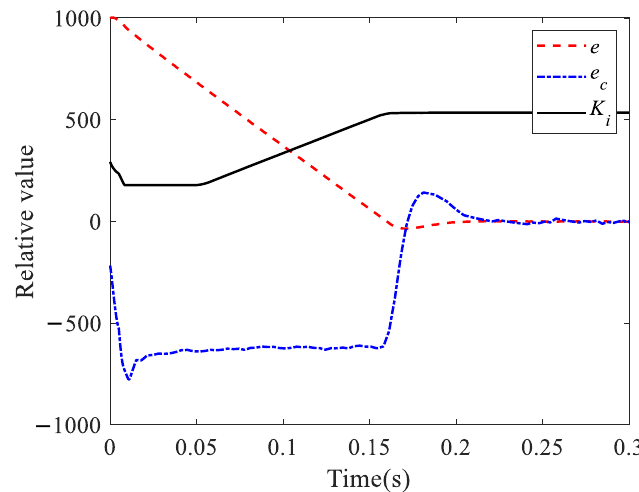
Figure 5. Adaptive sensitivity of K p .